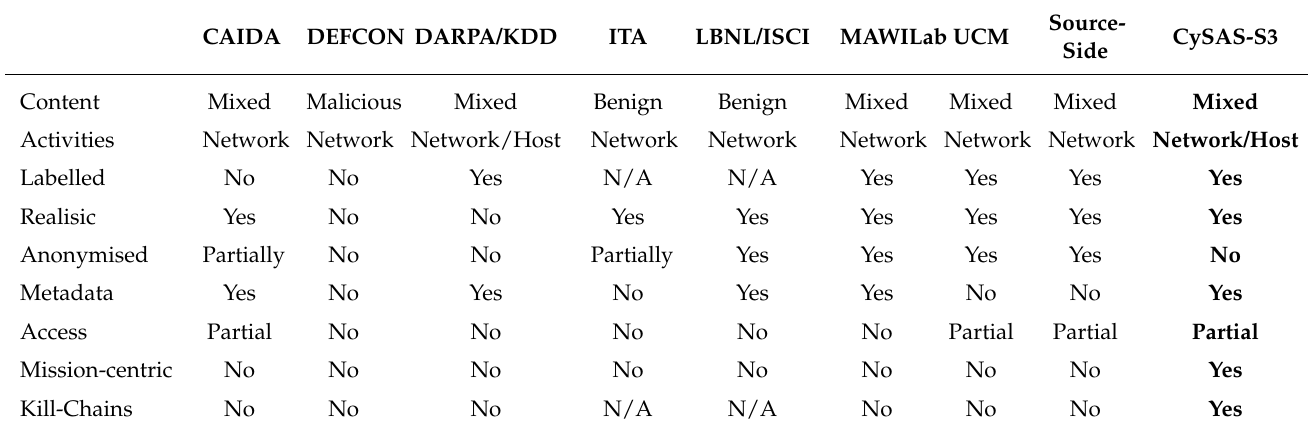
Table 1. Comparison of CySAS-S3 regarding key features of previous